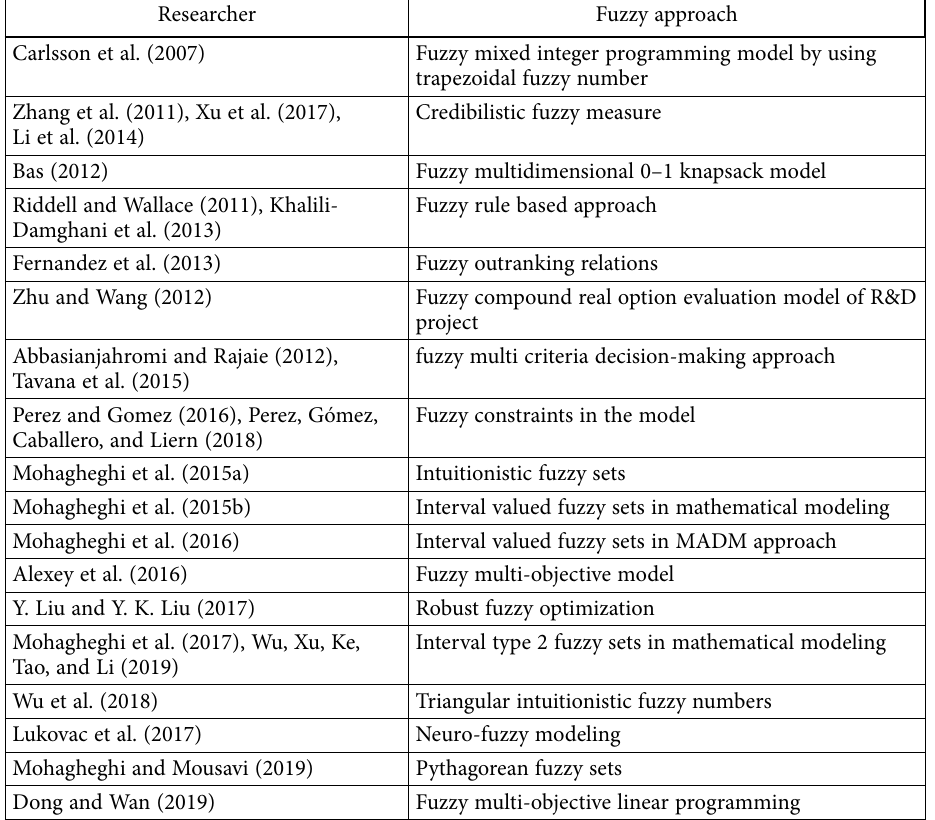
Table 10. Using fuzzy sets theory in PPS